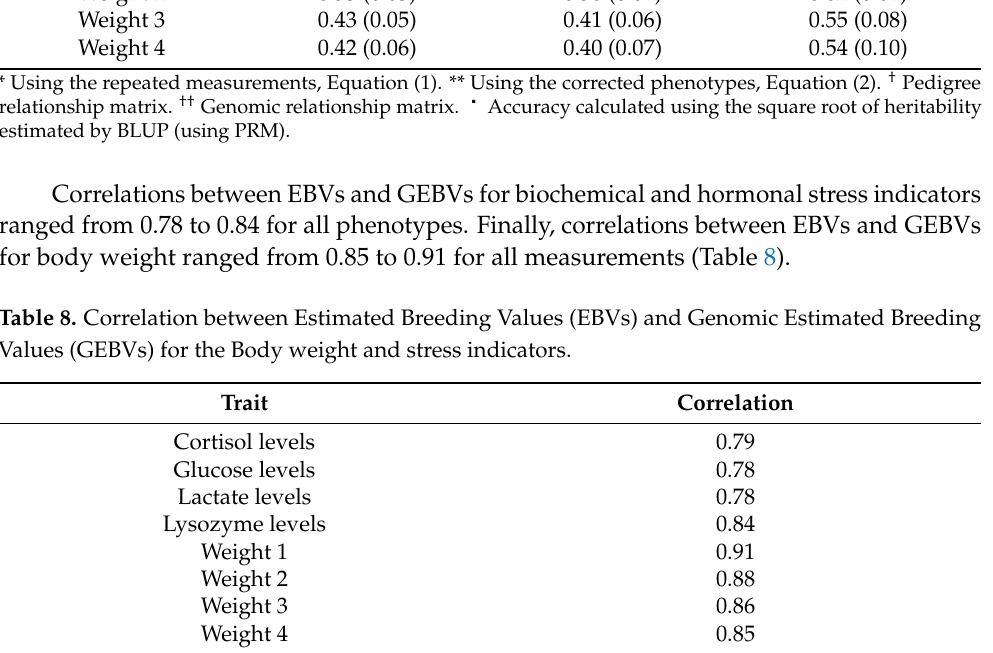
Table 7. Accuracy of estimation per trait per model. The standard error is illustrated in the parenthesis. Pedigree relationship matrix. †† Genomic relationship matrix. the square root of heritability estimated by BLUP (using PRM). Table 8. Correlation between Estimated Breeding Values (EBVs) and Genomic Estimated Breeding Values (GEBVs) for the Body weight and stress indicators.